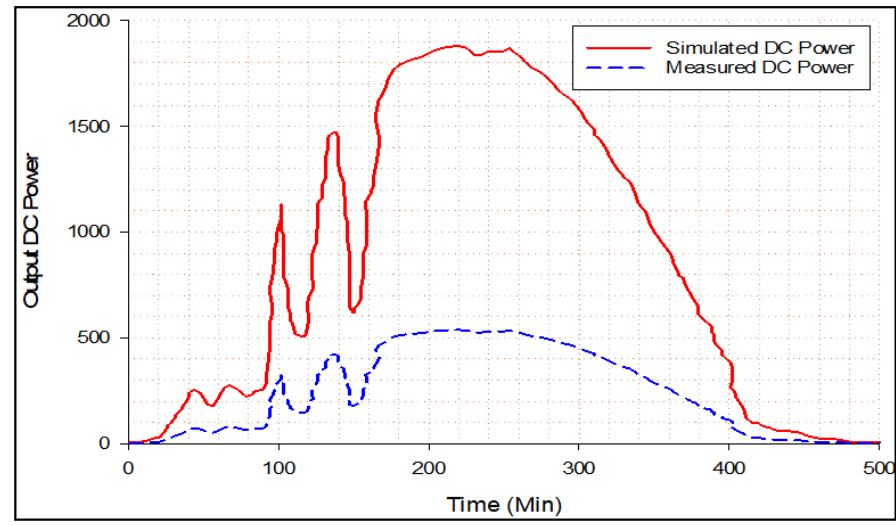
Figure 10. DC simulated power versus measured power (short-circuit fault operation).